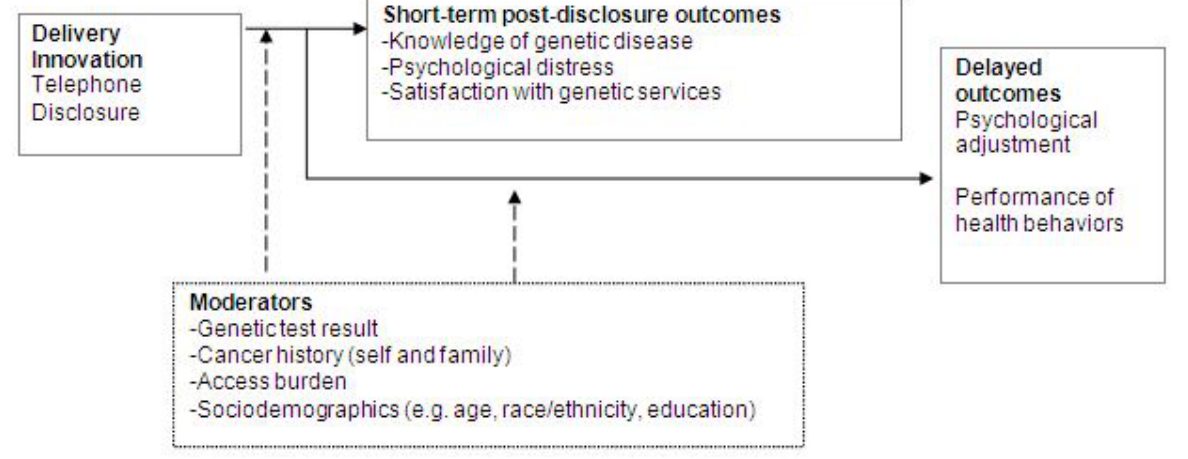
Figure 1. Theoretical model to evaluate innovations to delivery of genetic information (guided by the Self-Regulation Model of Health Behavior).